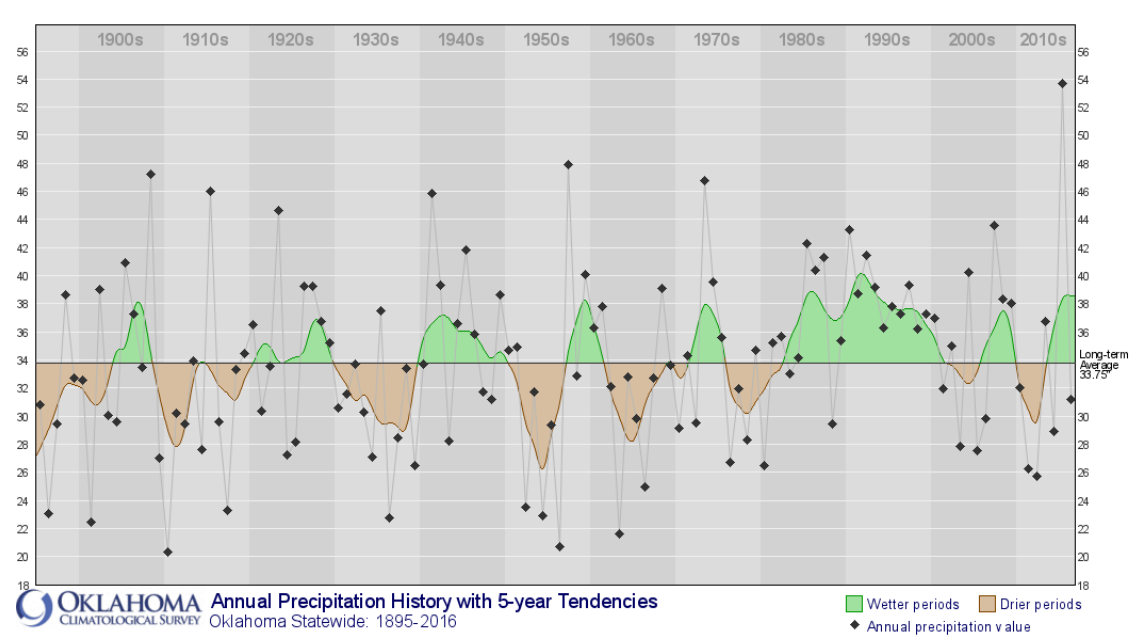
Source: Oklahoma Climatological Survey,